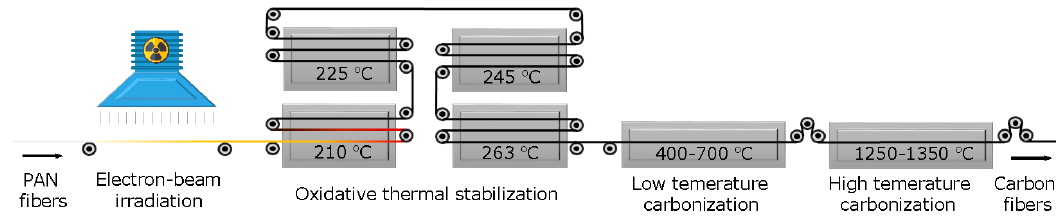
Figure 1. Schematic representation of the production line.